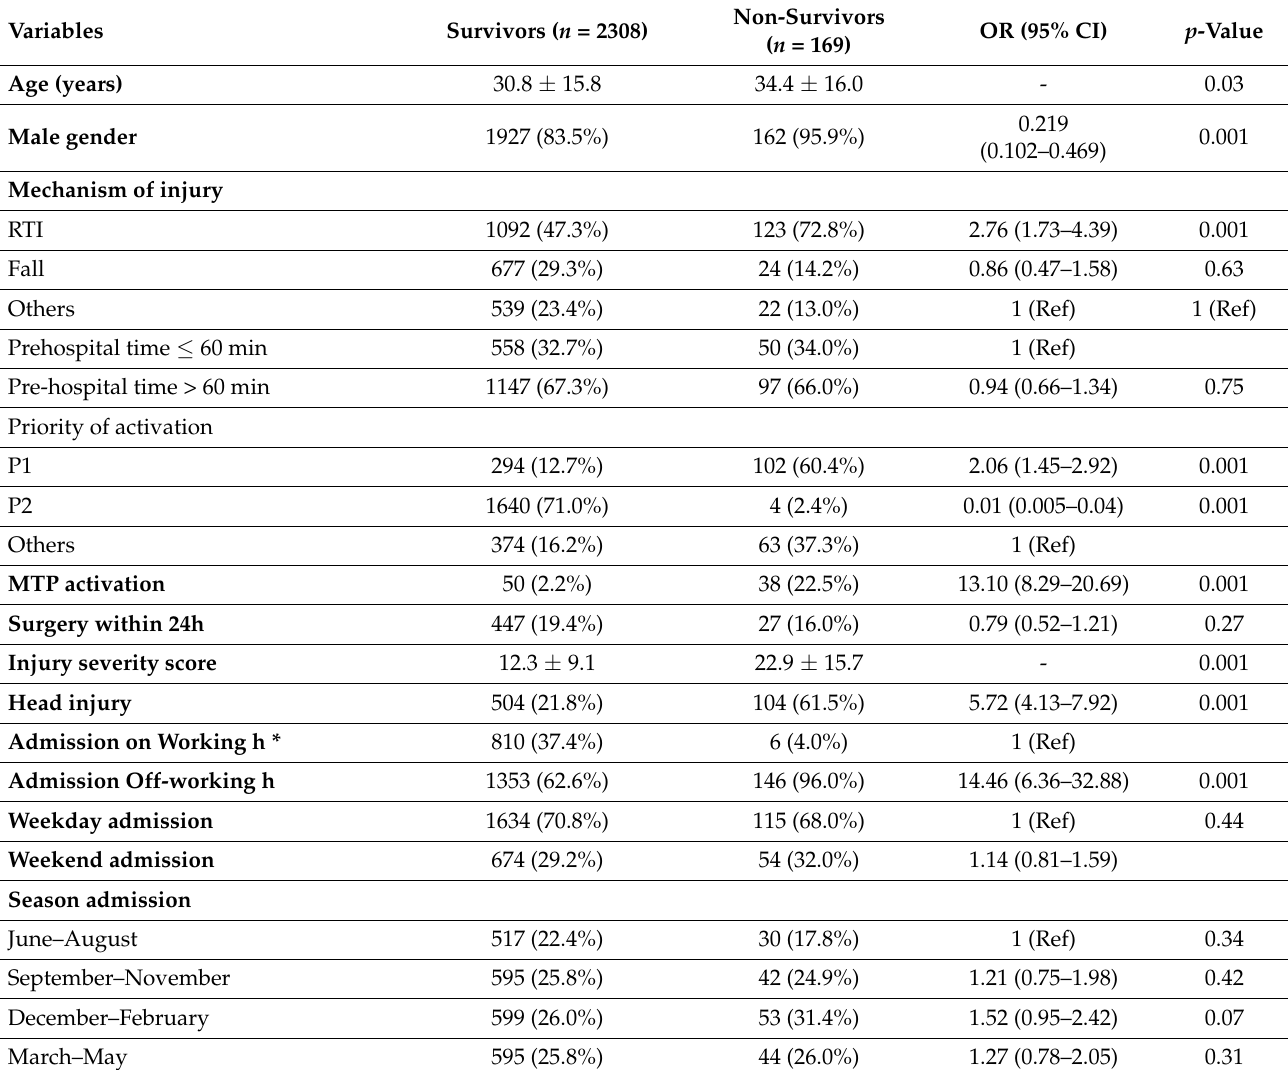
Table 4. Comparison between survivors and non-survivors among trauma